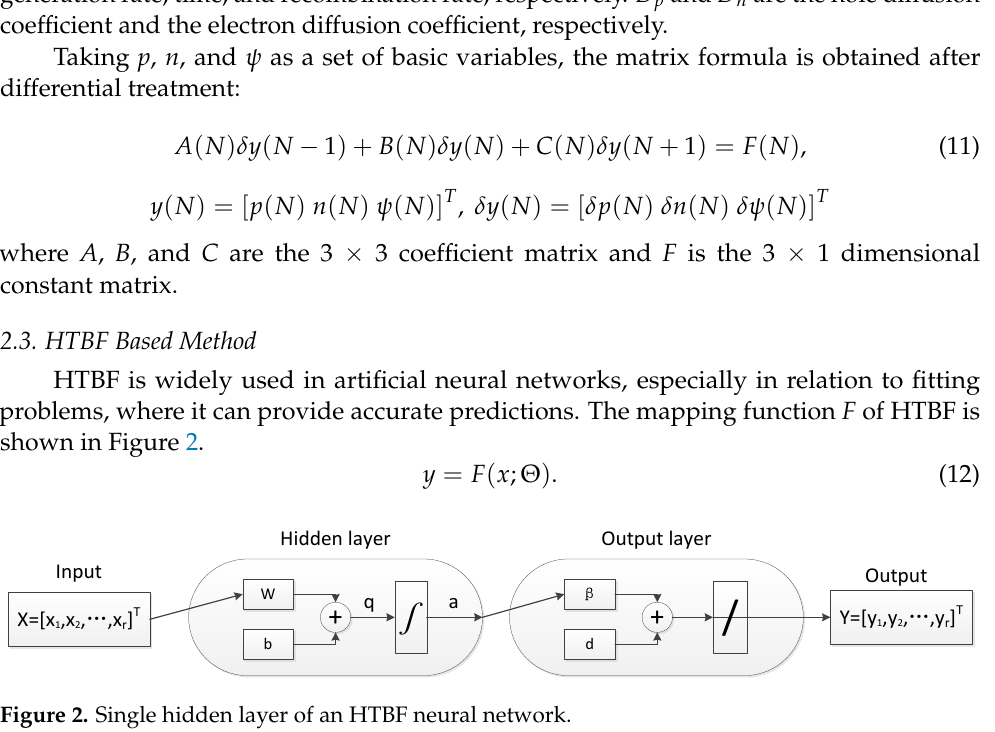
train parameter fitting Figure 3. Flow chart of the HTBF base method.